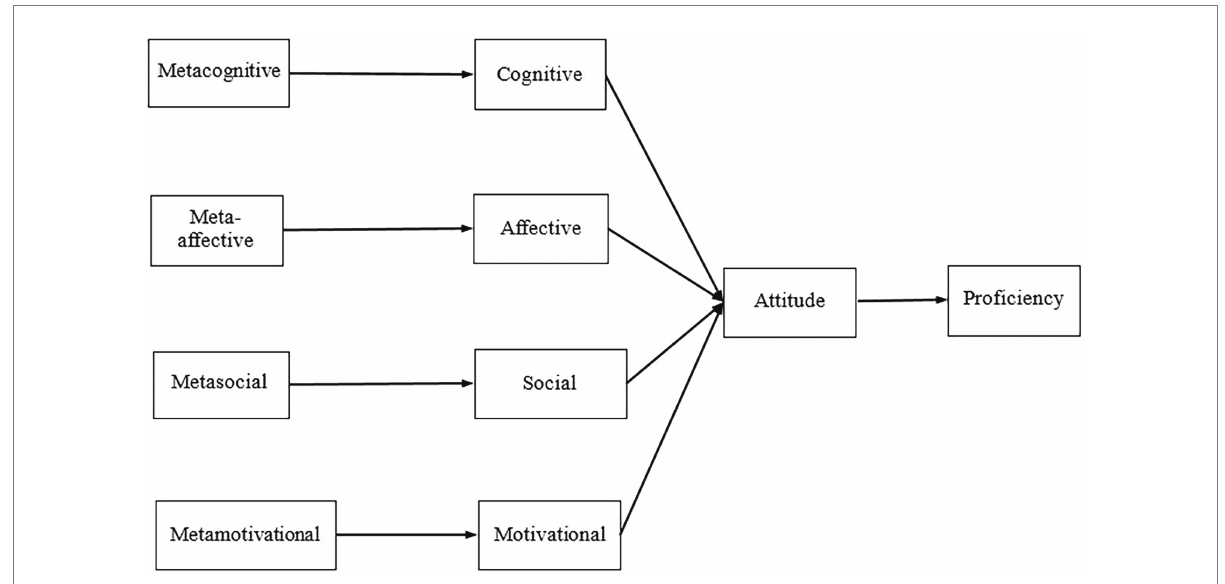
FIGURE 1 The theoretical model of strategy effects on proficiency through attitude.